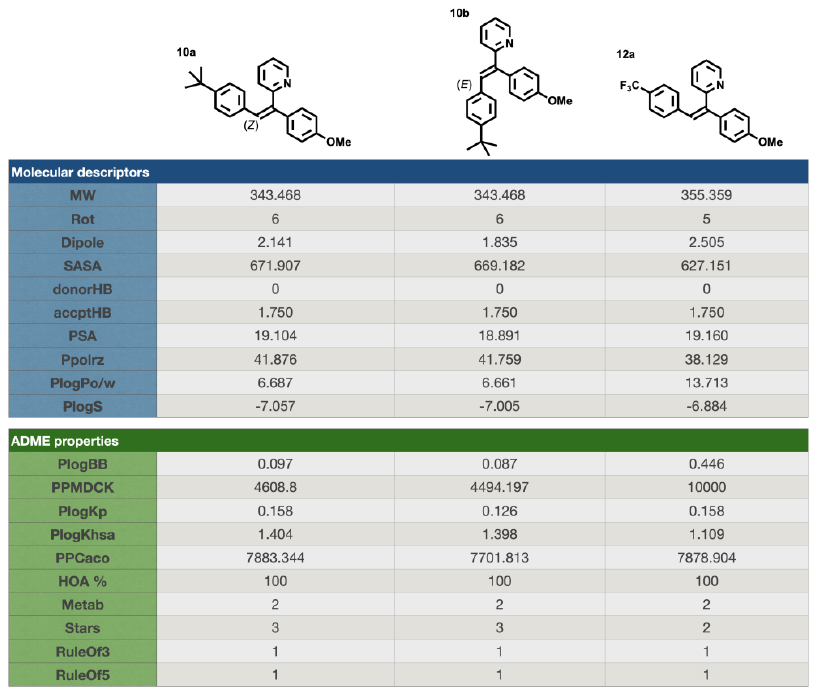
Figure 14. ADME properties and druglikeness of compounds 10a , 10b and 12a calculated with QikProp platform [38] MW: molecular weight of the molecule (recommended value: 130 – 725 g/mol).